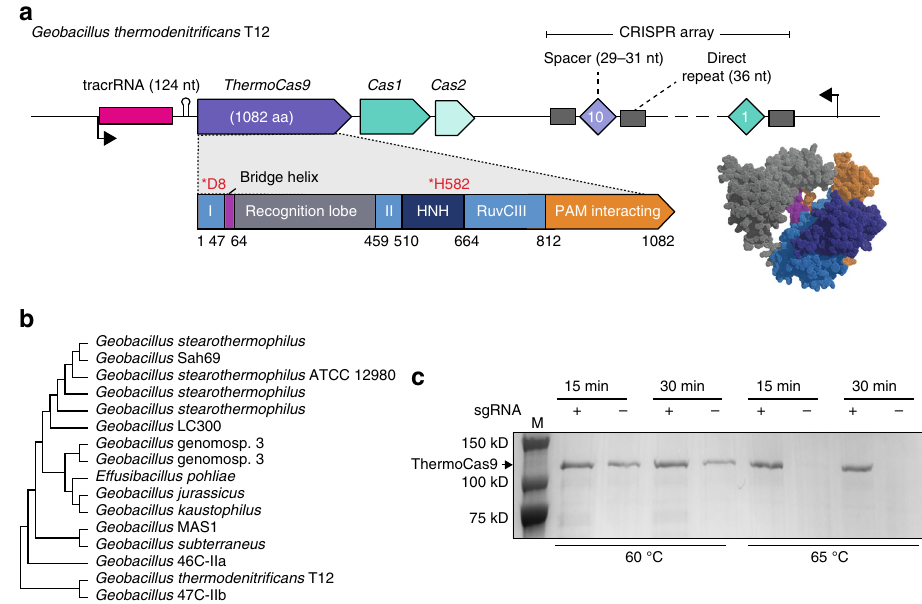
Fig. 1 The Geobacillus thermodenitri fi cans T12 type-IIC CRISPR-Cas locus encoding ThermoCas9. a Schematic representation of the genomic locus encoding ThermoCas9. The domain architecture of ThermoCas9 based on sequence comparison, with predicted active sites residues highlighted in magenta. A homology model of ThermoCas9 generated using Phyre 2 57 is shown, with different colors for the domains. b Phylogenetic tree of Cas9 orthologues highly identical to ThermoCas9. Evolutionary analysis was conducted in MEGA7 58 . c SDS-PAGE of ThermoCas9 after puri fi cation by metal-af fi nity chromatography and gel fi ltration. The migration of the obtained single band is consistent with the theoretical molecular weight of 126 kD of the apo-